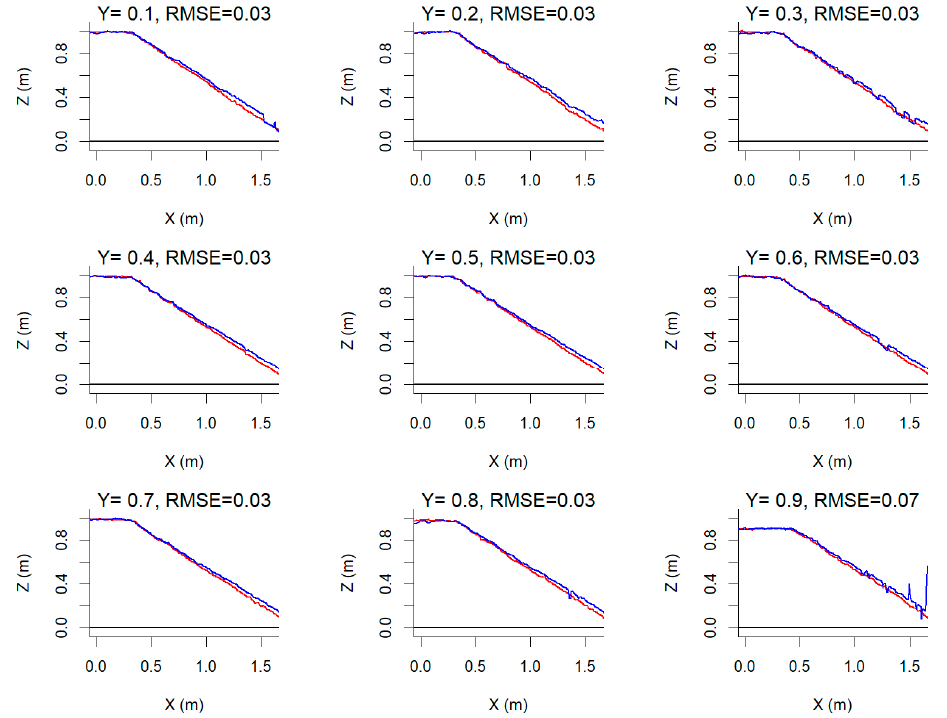
Figure 18. Longitudinal pro fi les of test U4; high-resolution DEM (red) and low-resolution DEM (blue); nine di ff erent pro fi les, with 0.1 being close to the back wall and 0.9 being near the glass wall (with pilot channel visible); calculated RMSE is shown for each pro fi le.